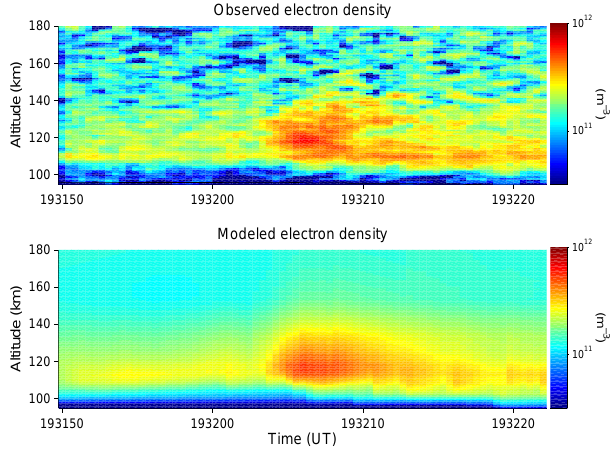
Fig. 12. Top: electron density profiles from EISCAT measure- ments, for the 1932 arc. Bottom: corresponding modelled electron Fig. 12. Top: Electron density profiles from EISCAT measure- density. The bite-out in the data at 19:32:10UT is not reproduced ments, for the 1932 arc. Bottom: Corresponding modelled electron by the model, and is believed to be caused by horizontal convection density. The bite-out in the data at 19:32:10 UT is not reproduced of plasma near the by the model, and is believed to be caused by horizontal convection of plasma near the arc.